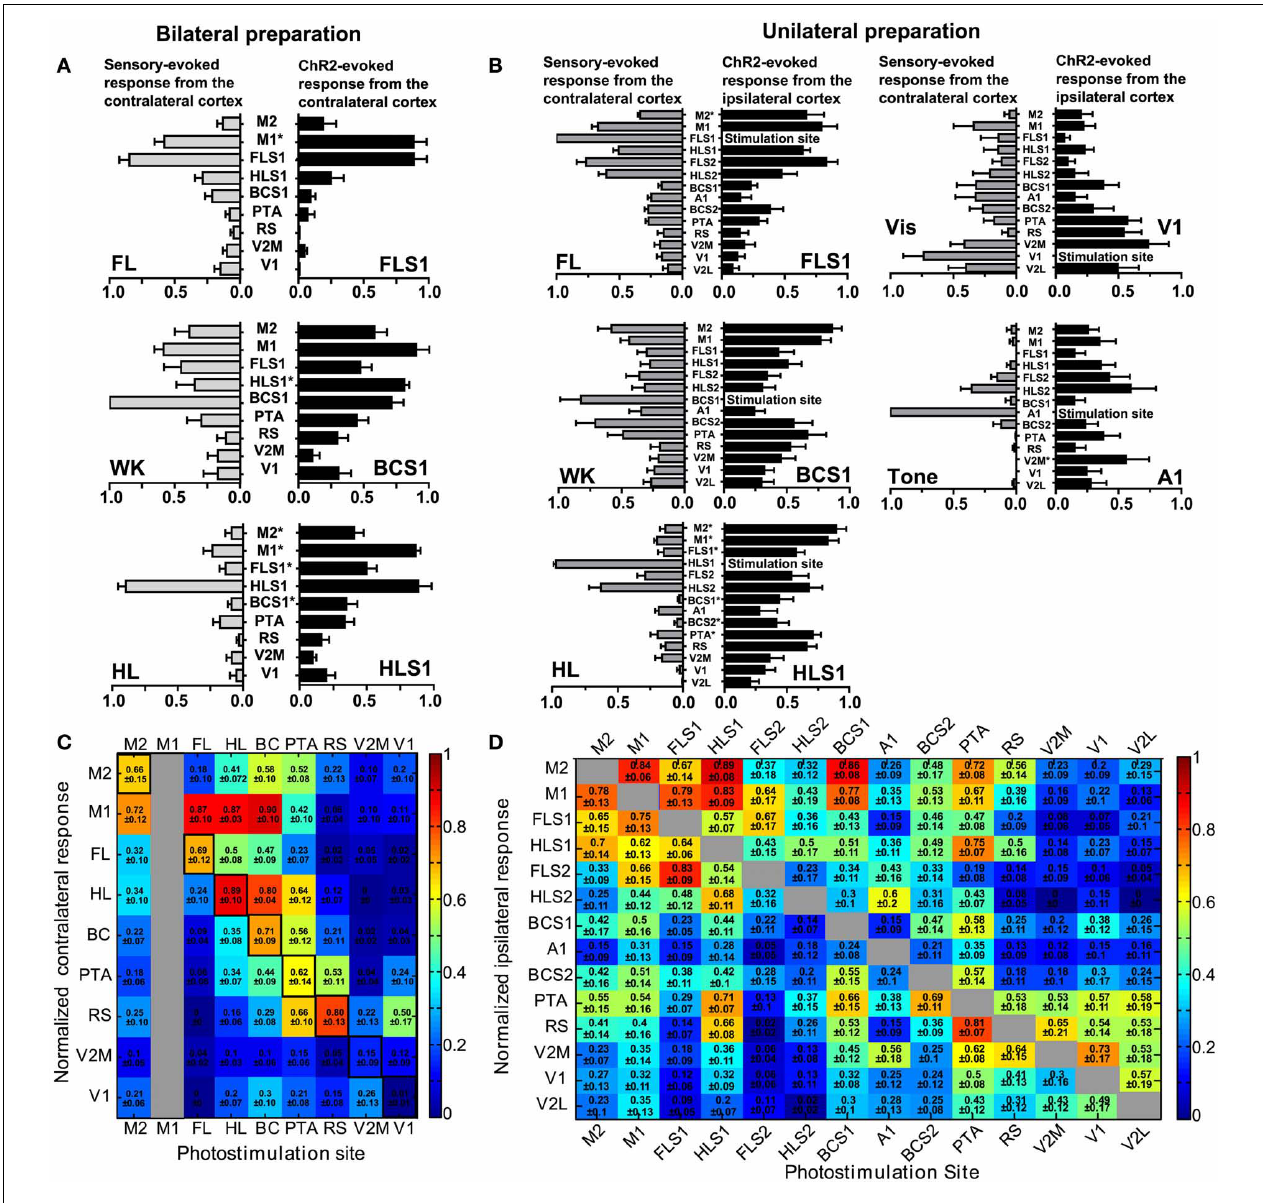
ANOVA post test). (C) Connectivity matrix derived from the bilateral preparation. Nine sites of photostimulation are indicated along the x -axis, and nine ROIs are indicated along the y -axis. M1 was not a photostimulation site (gray column) but was used as a ROI forVSD responses.The responses represent the integratedVSD response in the hemisphere contralateral to photostimulation at 20ms after photostimulation. Responses were normalized to the maximum response per stimulation site, per animal, and then averaged across ten animals. In cases where the response was less than four times the SD of the baseline, it was assigned a value of zero indicating no response. (D) Connectivity matrix derived from the unilateral preparation. Fourteen sites of photostimulation are indicated along the x -axis, and 14 ROIs are indicated along the y -axis.The responses represent the integratedVSD response at 20ms after photostimulation within the hemisphere where photostimulation occurred. Responses are not shown for the site of stimulation (gray boxes). Responses were normalized to the maximum response per stimulation site, per animal, and averaged across six